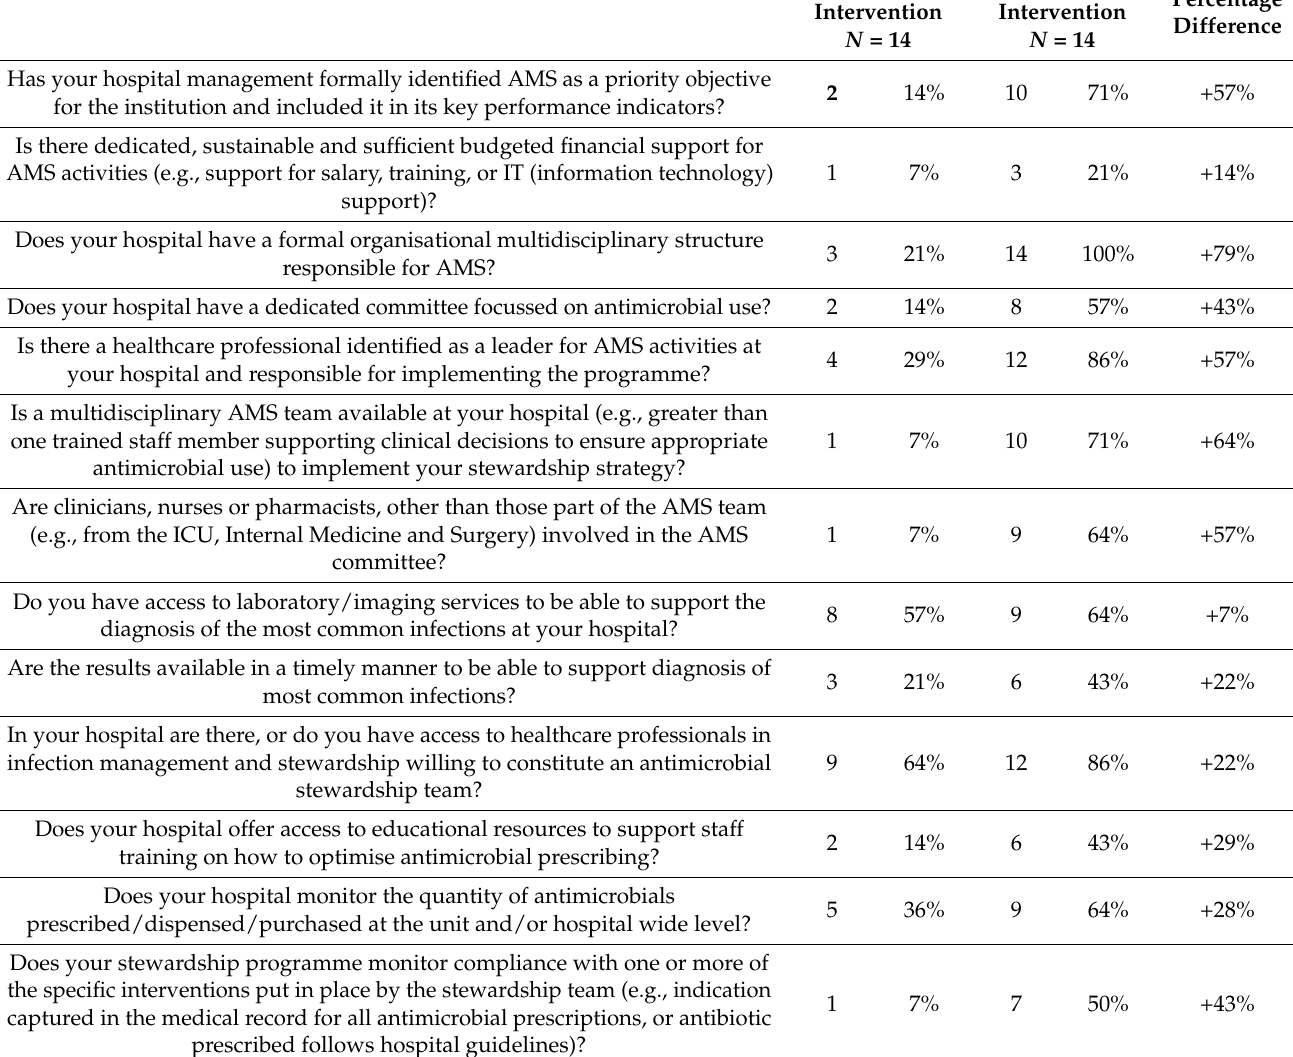
Table 1. Comparison of selected AMS checklist results pre- and post-AMS intervention that formed part of the CwPAMS projects. The numbers indicate the total number of sites that agreed with the item in question. Percentages (out of 14 sites) are provided alongside the numbers. The final column shows post-intervention improvement through the percentage increase. Pre-AMS Intervention N = 14